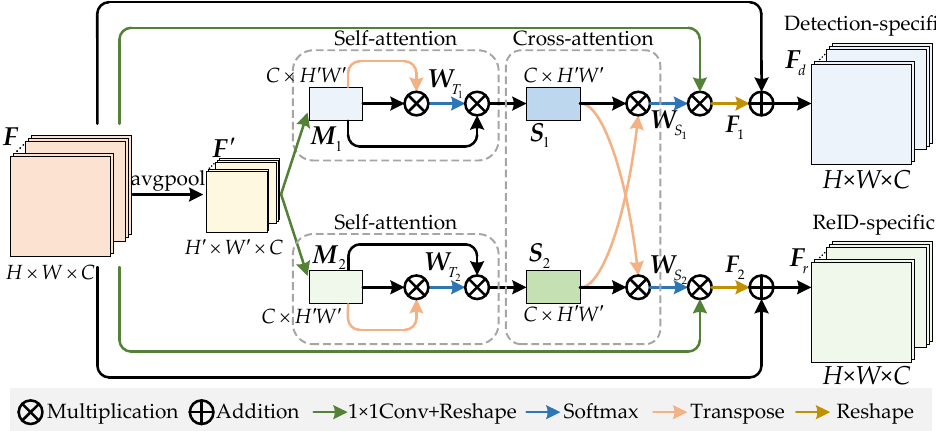
Figure 3. The architecture of the FDN. Given the original shared feature map F , the FDN decouples F into two task-specific representations F d and F r